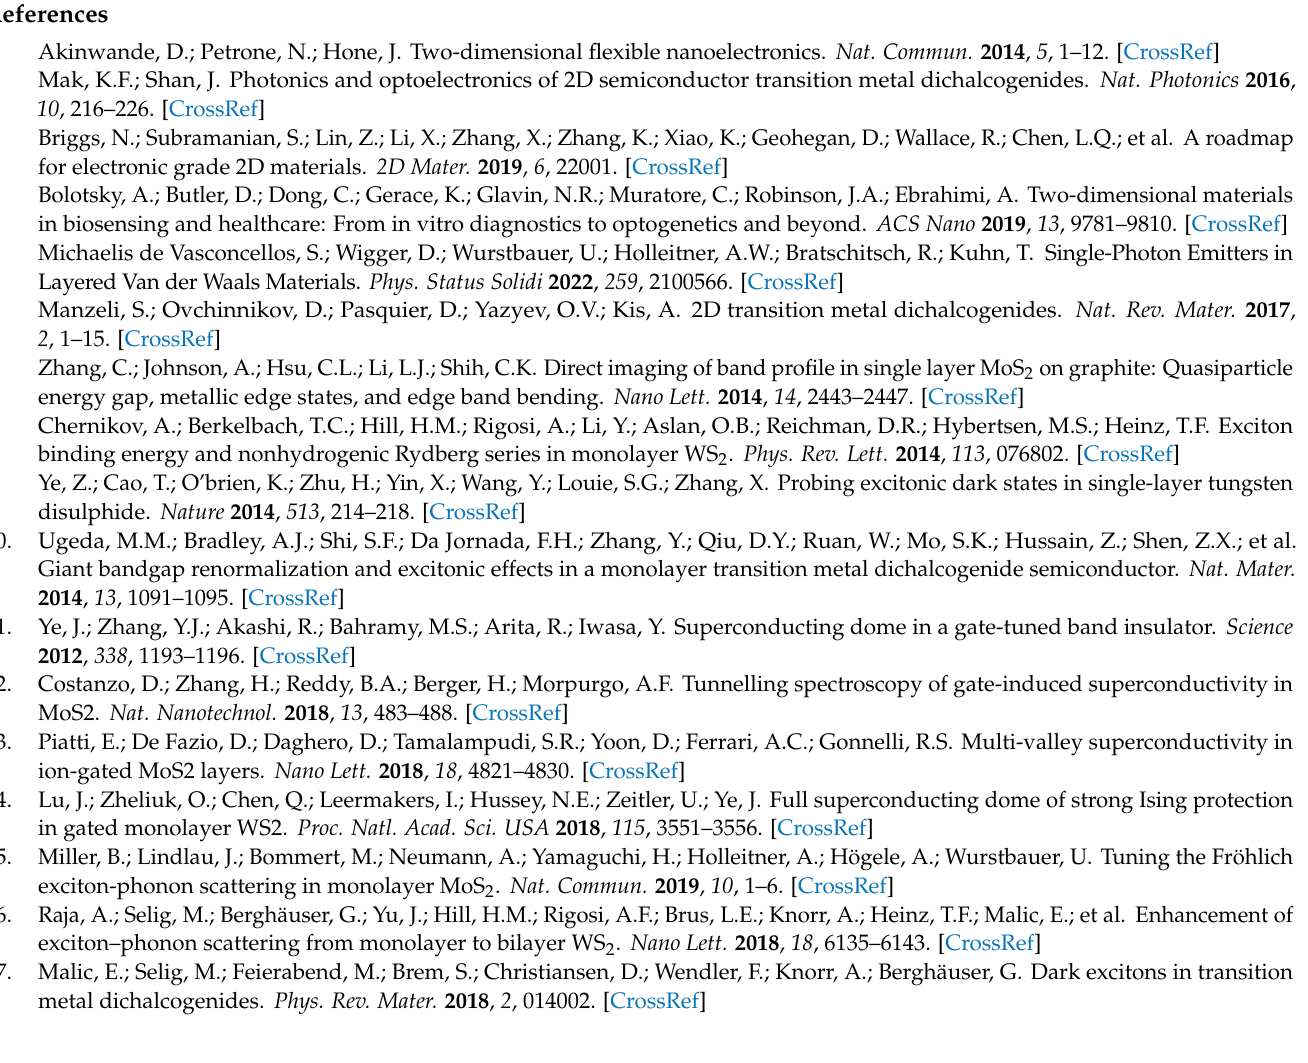
spectra; Figure S2: Hysteresis in gate voltage dependent measurements; Figure S3: Temperature de- pendent PL spectra of a WS 2 ML; Figure S4: Ellipsometry spectra of different layer structures; Figure S5: Optical micrograph and PL maps of a WS 2 ML; Figure S6: Comparison of the gate voltage depen- dence of the integrated intensities from two different WS 2 ML FET structures for gate-up and down sweeps; Table S1: Fit values of semi-empirical Varshni fits of temperature dependent optical bandgaps extracted from PL peak positions. References [41,55] are cited in the Supplementary